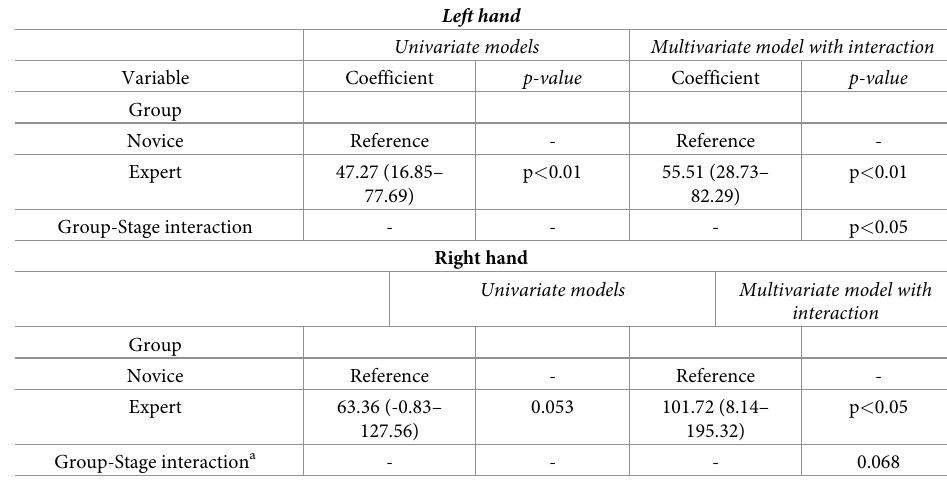
Table 4. Univariate and multivariate linear models to determine differences in jerk by group, session, and their interaction, for both